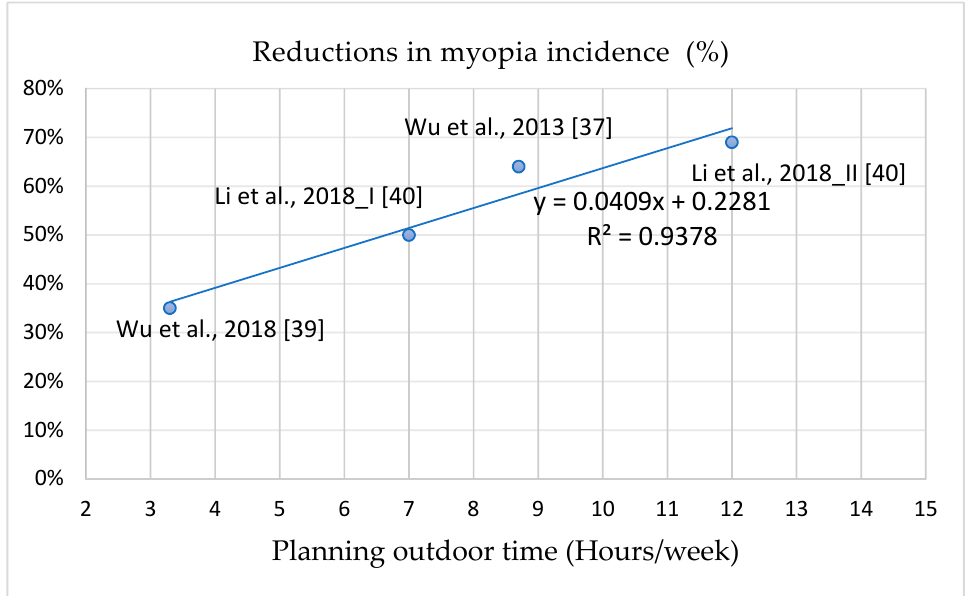
Figure 5. The dose-response effect between reduction ratios in incident/prevalent myopia and outdoor time at school.